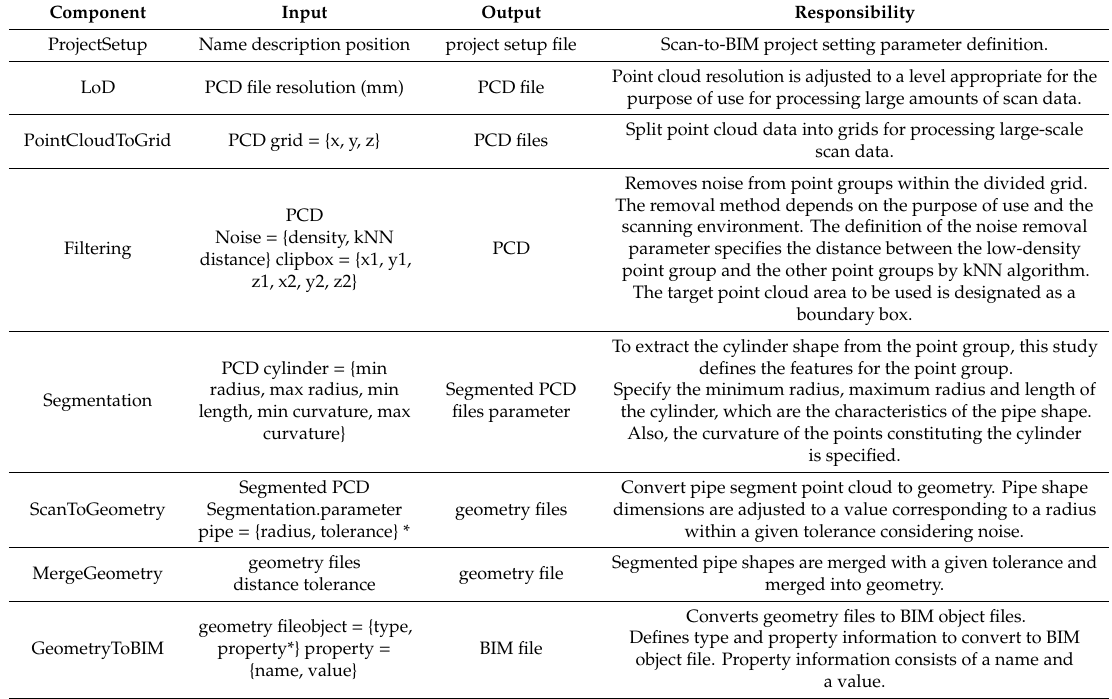
Table 3. Scan-to-BIM pipeline component definition (* = multiple).